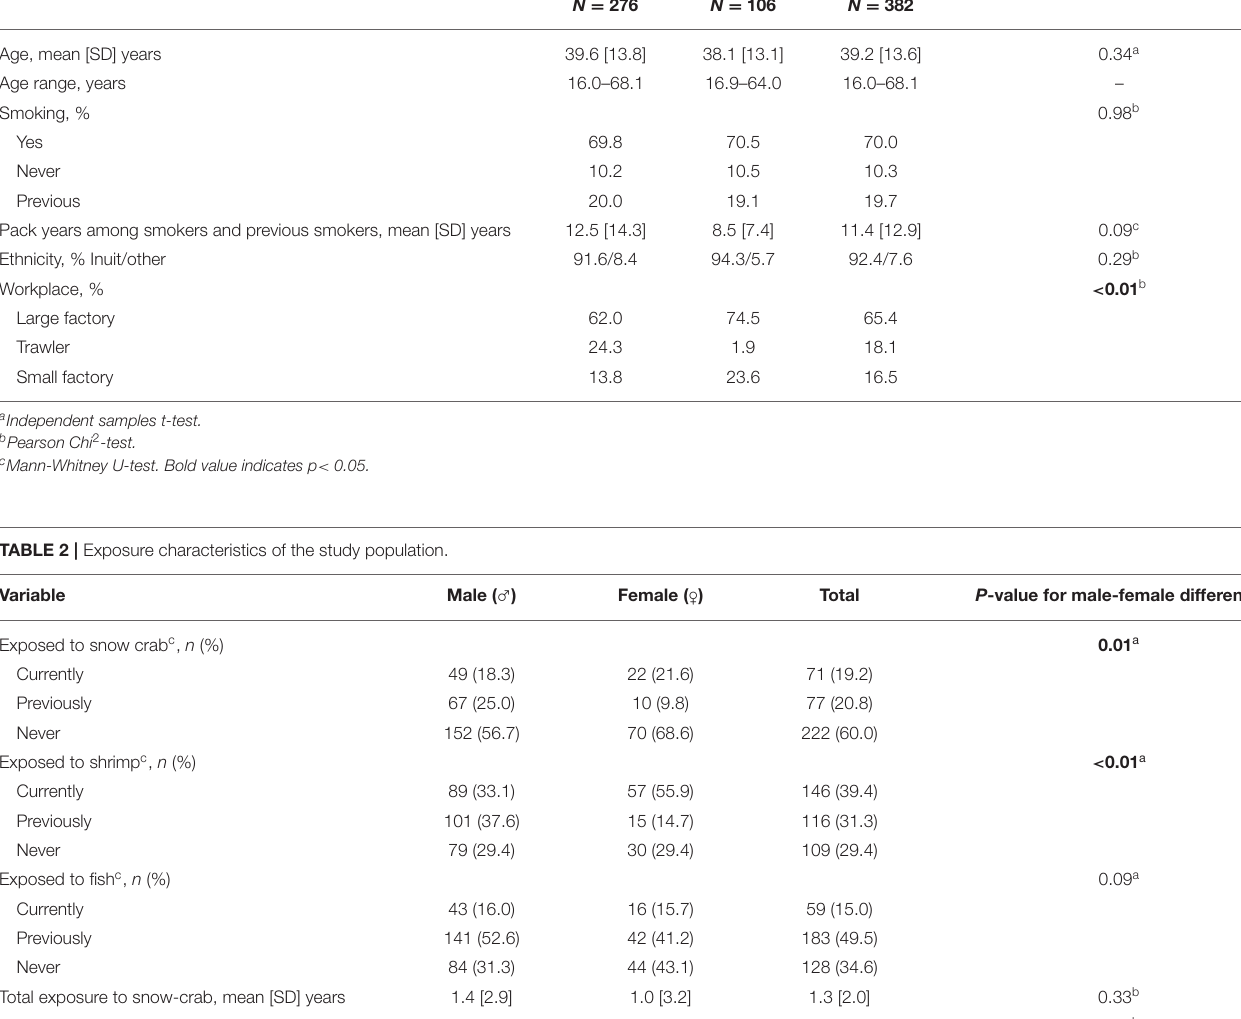
TABLE 1 | Characteristics of the study population. Variable